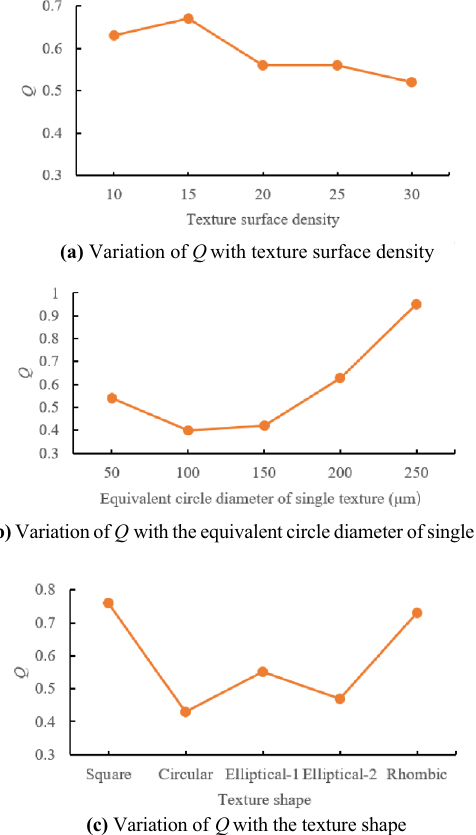
Figure 6 Variation of comprehensive evaluation value of disassembly damage ( Q ) with 3 factors